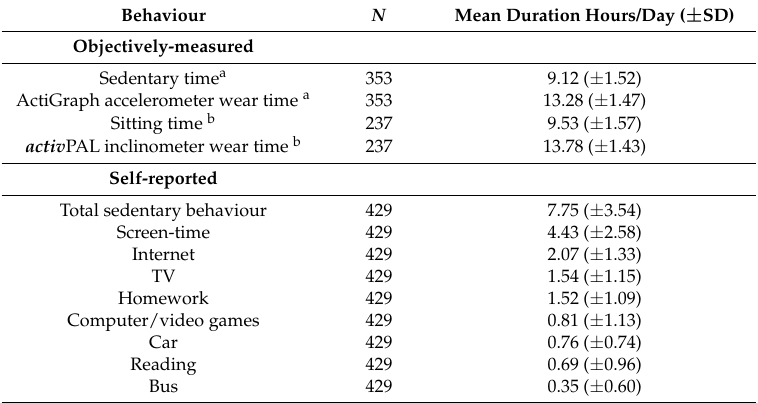
Table 2. Mean ( ± SD) duration (hours/day) of objectively measured daily sedentary, daily sitting time and self-reported sedentary behaviours outside school